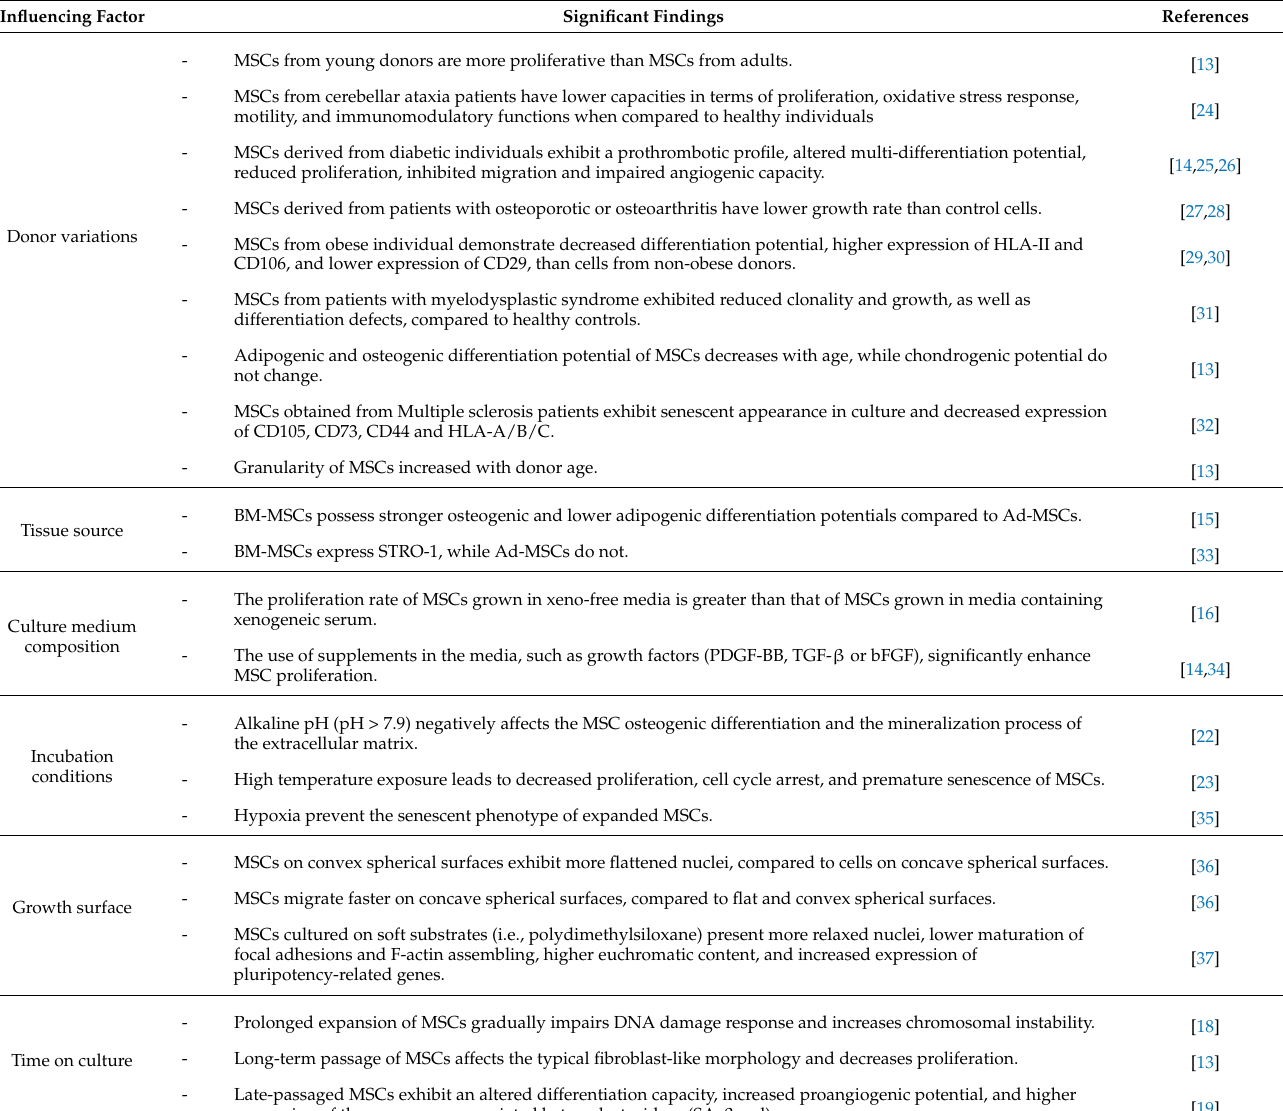
Table 1. Major factors affecting the heterogeneity of MSC during in vitro